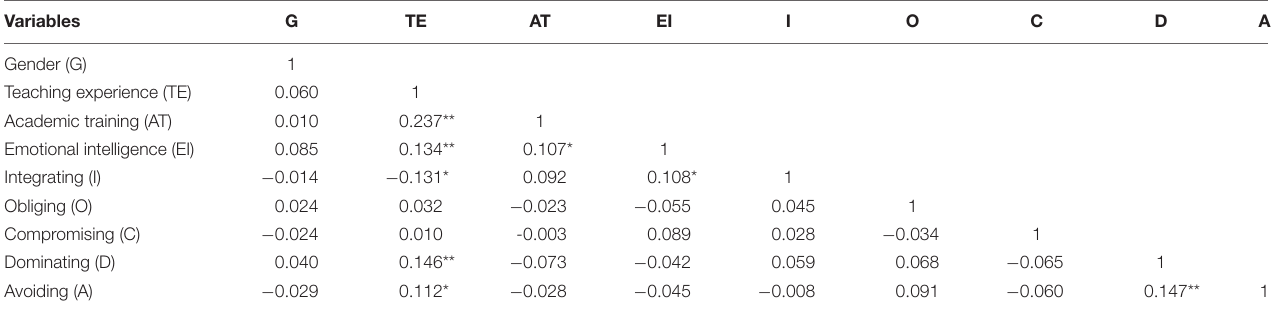
TABLE 3 | Pearson’s correlation between the variables of the model. Variables G TE